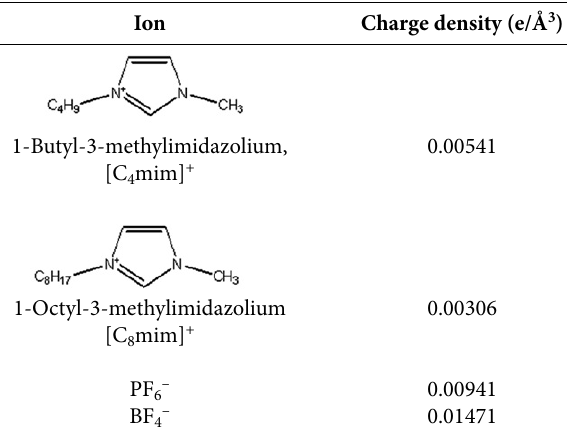
Table 2. Chemical structures and charge densities of ionic parts of the ionic liquids used Ion Charge density (e/Å 3